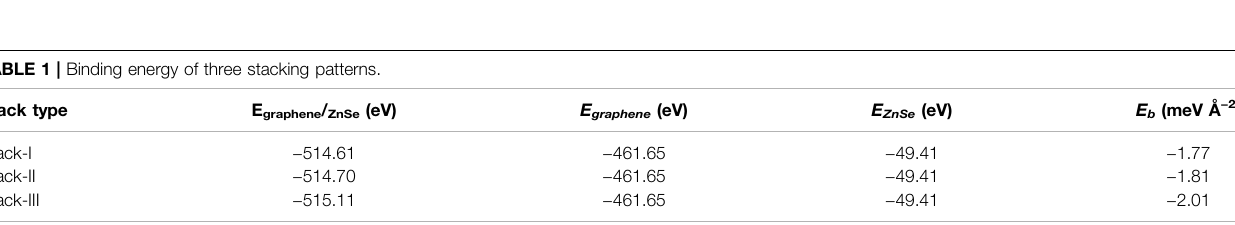
TABLE 1 | Binding energy of three stacking